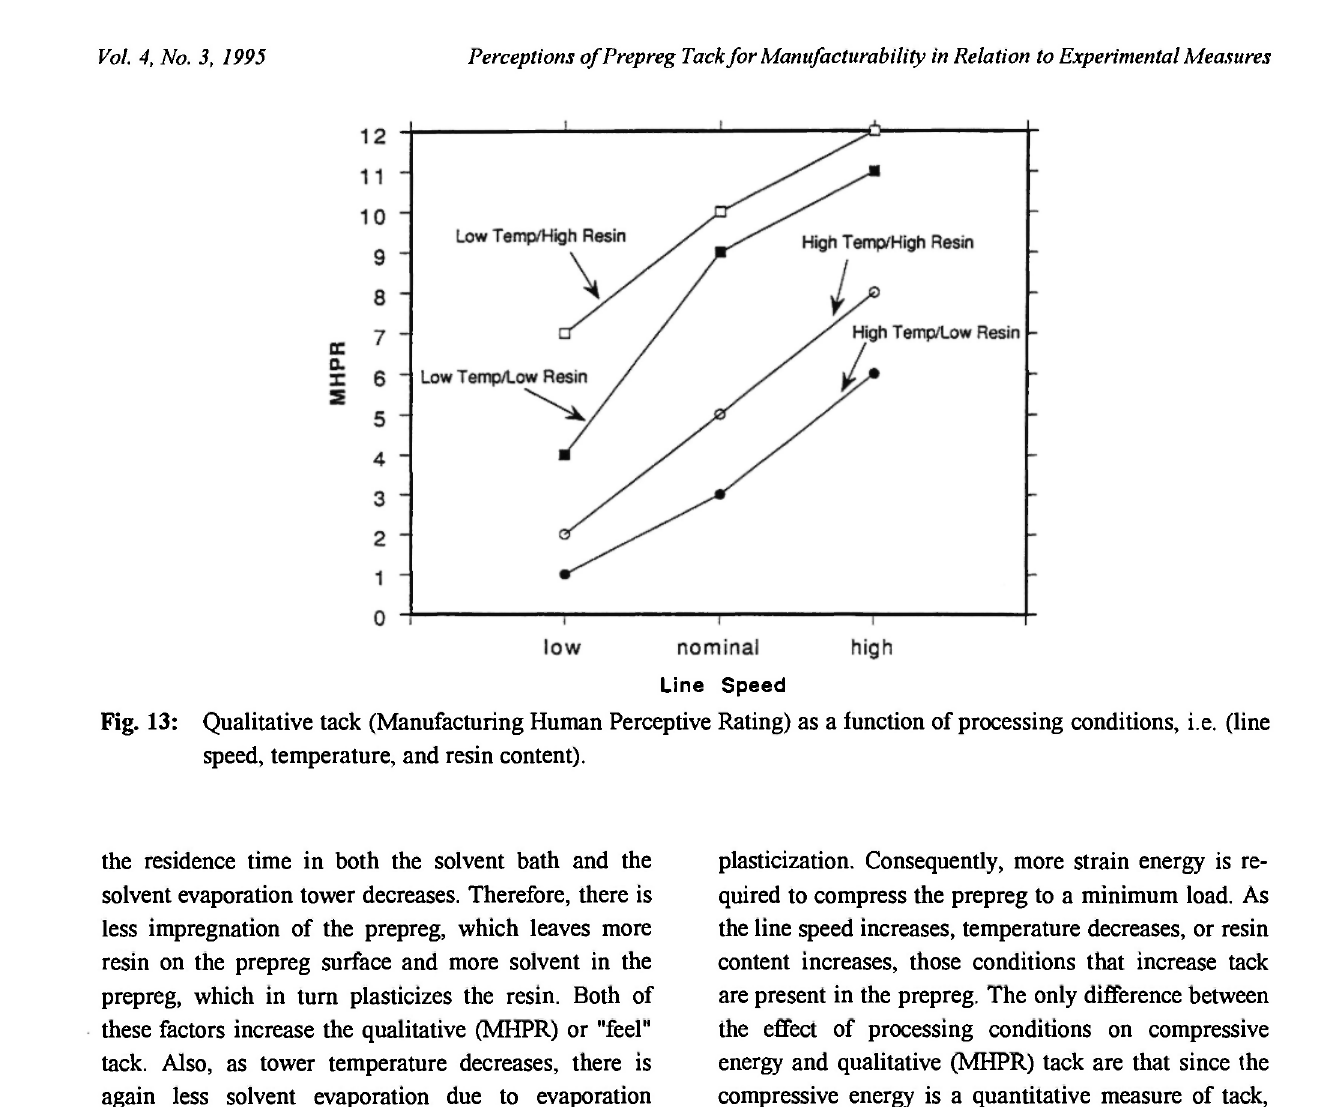
Fig. 13: Qualitative tack (Manufacturing Human Perceptive Rating) as a function of processing conditions, i.e. (line speed, temperature, and resin